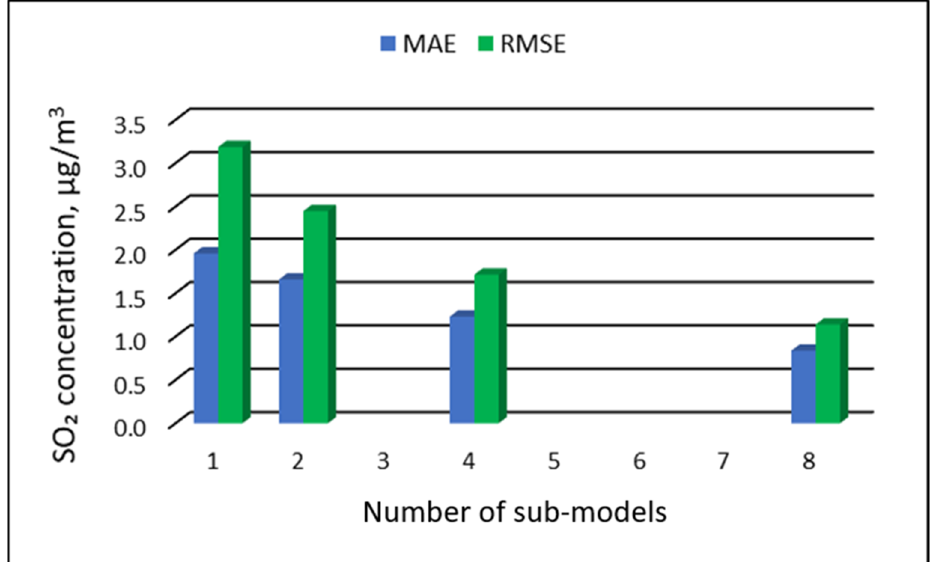
Figure 20. Overall MAE and RMSE values for SO 2 concentration prediction in RVS models depend- ing on the number of created sub-models, Z ł oty